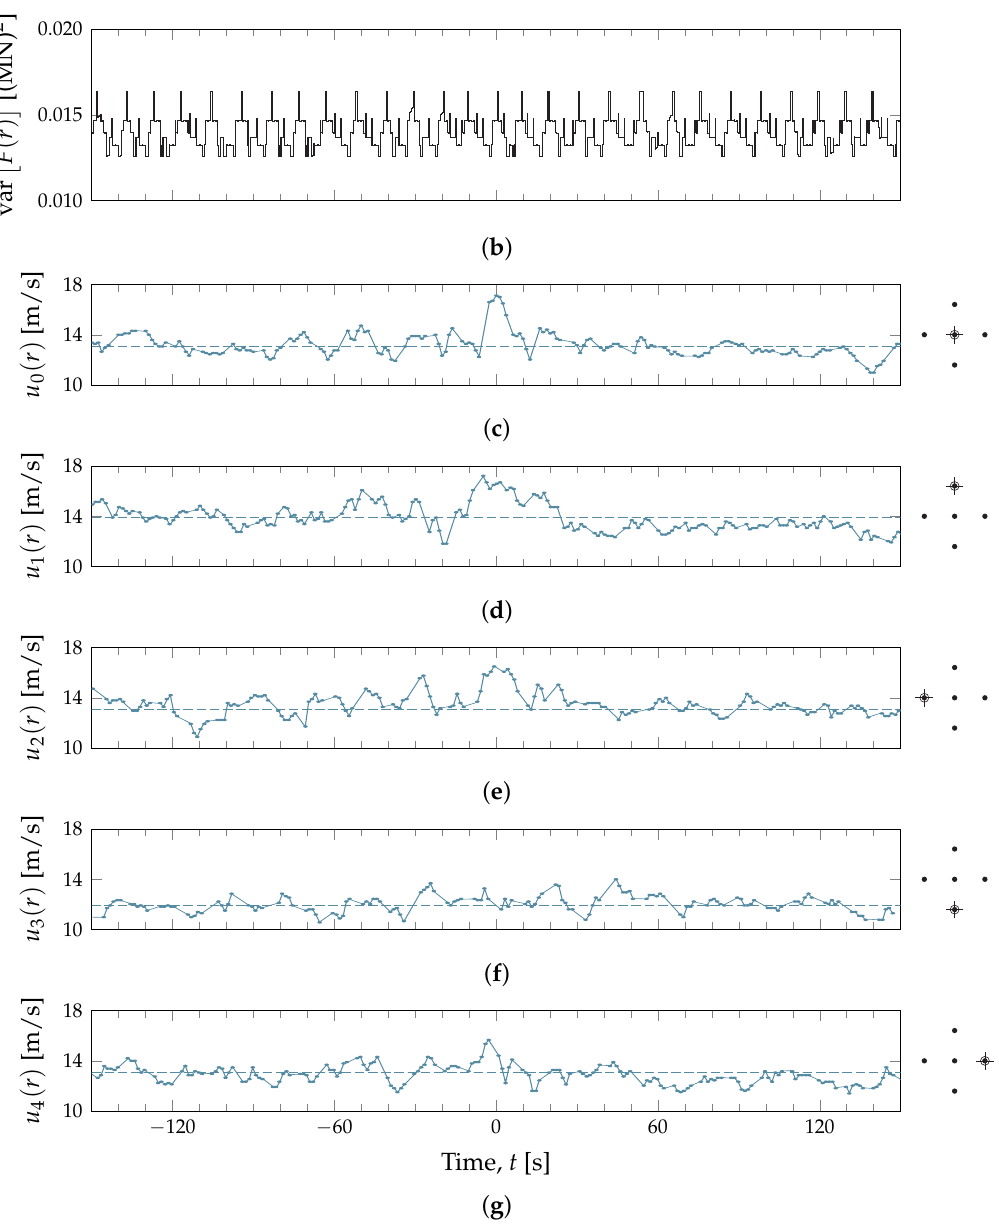
Figure 6. Construction of an estimated along-wind force, ˆ F ( a ), and its variance ( b ), from five individual velocity signals, u 0 , . . . , u 4 ( c – g ) at the r = − 140 m range gate (where 0–4 are the beam positions). The time series are centered around a gust event at t =